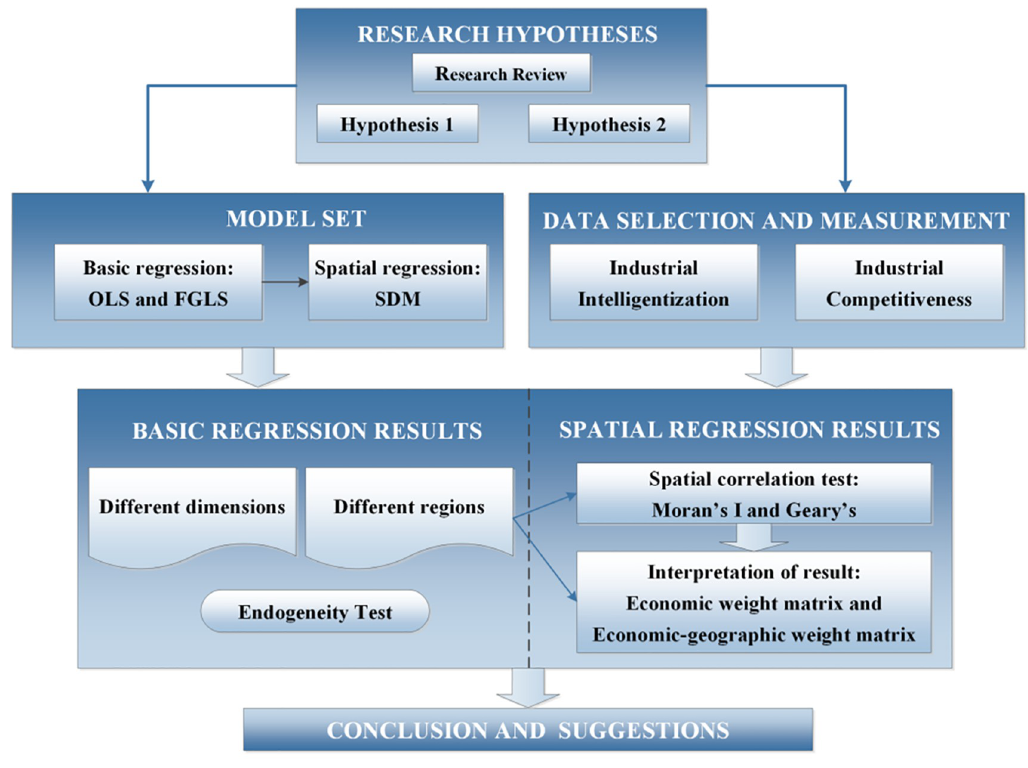
Fig 3. Framework diagram of this